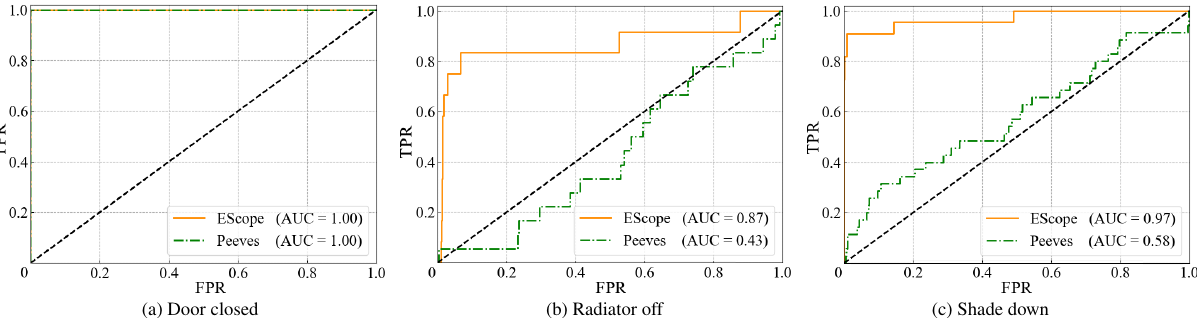
Fig. 6 ROC curves of three